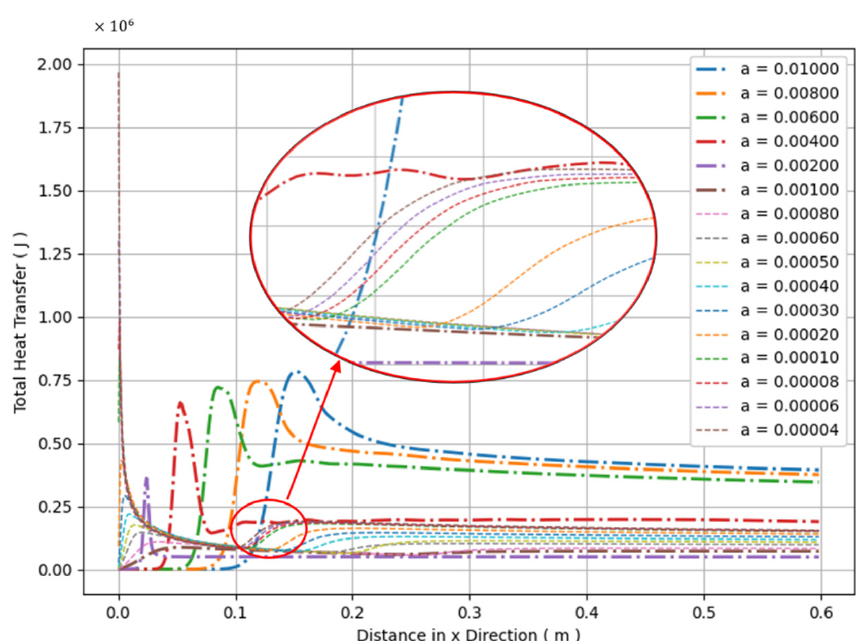
Figure 3. Grid convergence study of cell ratio ‘a’.